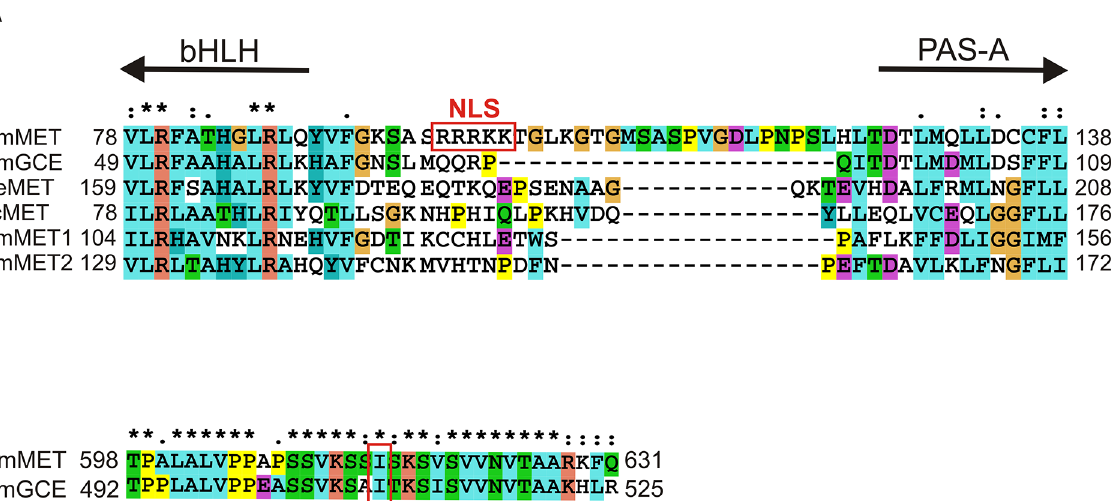
Fig 7. Alignment of the MET/GCE sequences. (A) Area that links bHLH and PAS-A domains from MET/GCE Drosophila melanogaster , MET Aedes aegypti , MET Tribolium castaneum and MET1/MET2 Bombyx mori . Red box indicate NLS unique for Drosophila melanogaster . (B) Drosophila MET598-631/ GCE492-525 encompassing predicted NES. Red box indicate GCE residue I509 predicted as